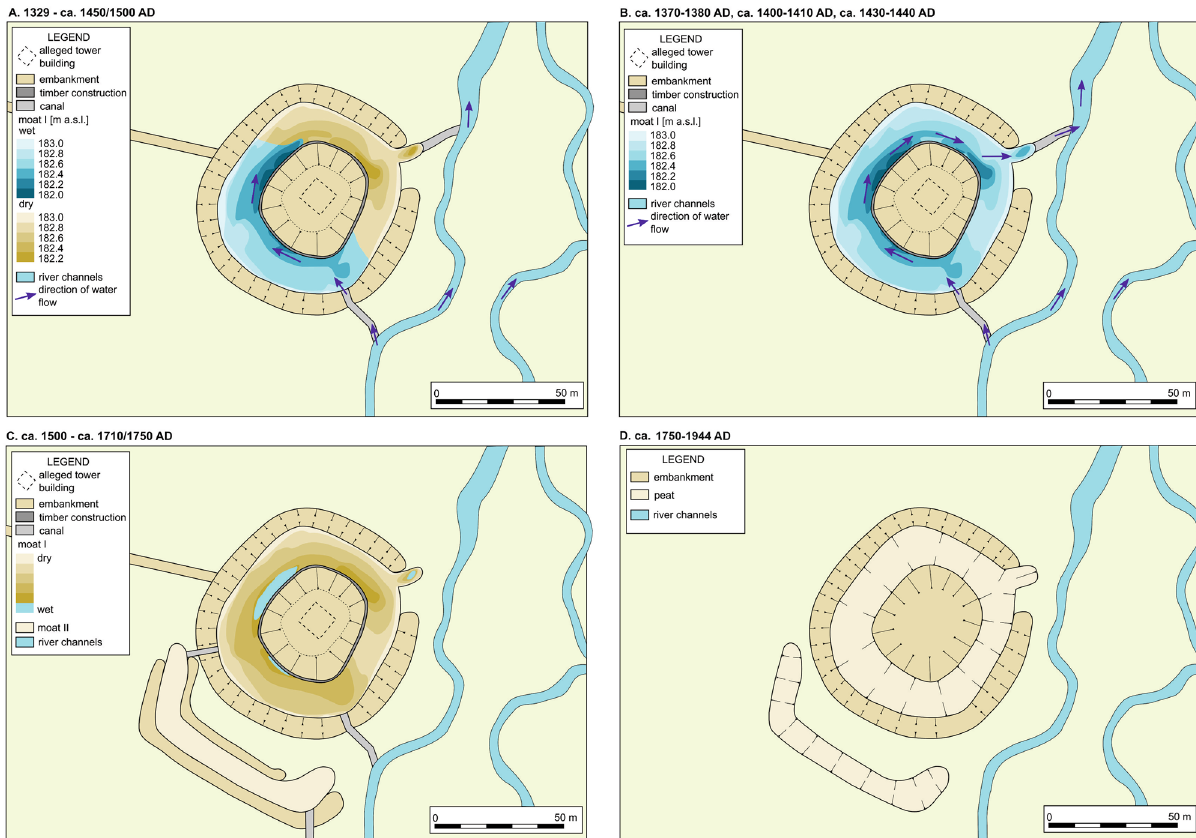
Figure 6. Phases and episodes of different moat states over time: ( A ) limnetic stage only in the southern (deeper) part of the main moat (1329—ca. 1450/1500 AD); ( B ) – limnetic stage in the whole main moat, episodes of higher water level in the NE part of the moat, indicated by Y2, X2 and Y1 subclusters in the core RP W1 (ca. 1370–1380 AD, ca. 1400–1410 AD, ca. 1430–1440 AD); ( C ) construction of the southern secondary moat, telmatic stage (ca. 1500—ca. 1710/1750 AD); ( D ) terrestrial stage in the both moats up to their covering with the material from the stronghold’s mound in 20th century AD (ca. 1750–1944